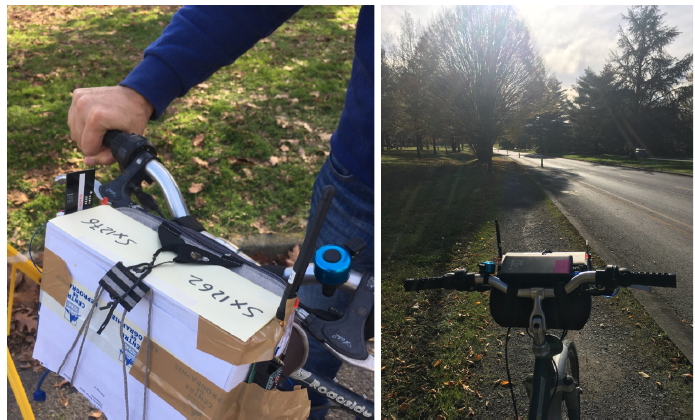
Figure 5. Comparing CAD performance on SX1262 and